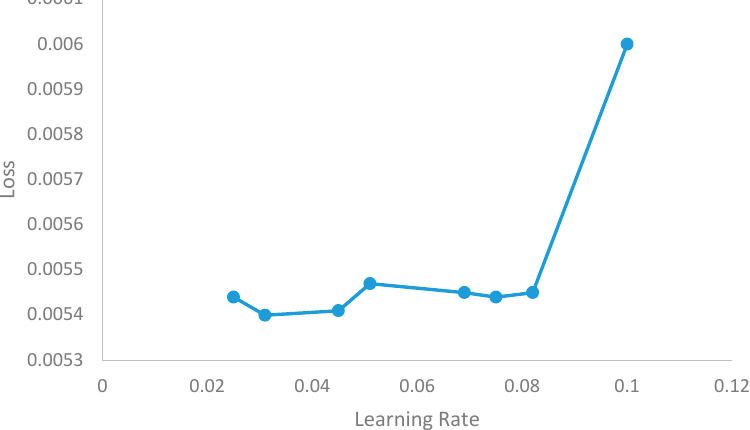
Figure 6. Gradual decrease in Learning rate for Intensified LSTM.